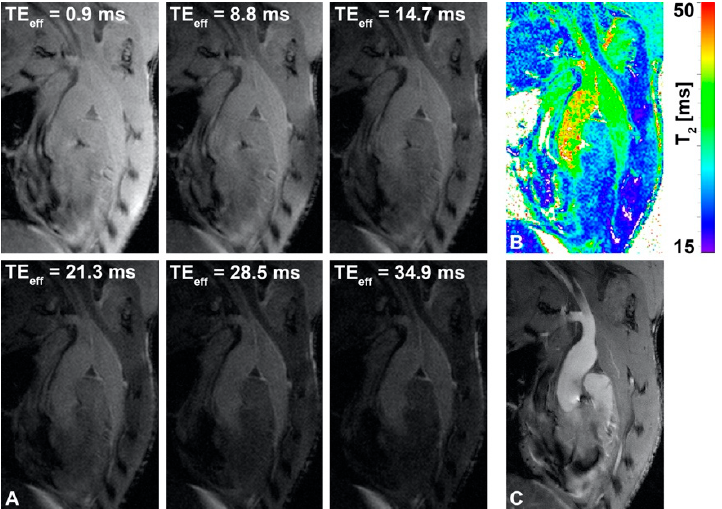
Figure 2. T 2 -weighted images and T 2 -value map . ( A ) T 2 -weighted images with 6 different effective echo times (TE eff ) and ( B ) false-color T 2 -value map of BCA view pre-injection . ( C ) T 1 -weighted anatomical reference image.